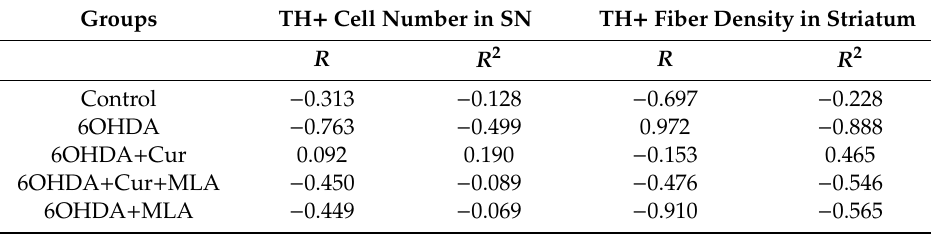
Table 1. Correlation between the number of TH-positive cells in the SN and striatal TH-positive fiber density, and performance of animals in di ff erent study groups in the apomorphine-induced rotation test, as assessed by simple linear regression analysis, expressed as R and adjusted R 2 values. Groups TH + Cell Number in SN TH + Fiber Density in Striatum R R 2